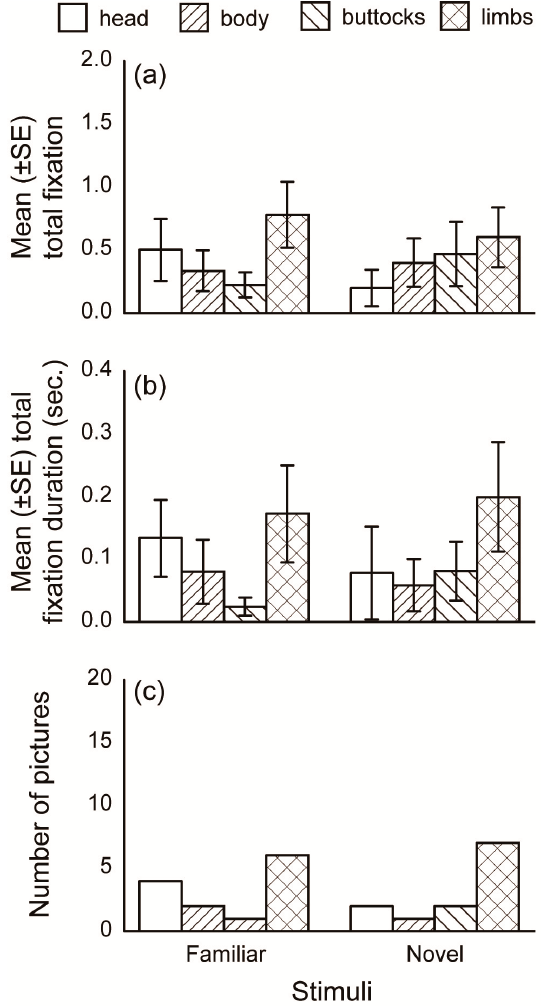
Figure 5. Mean (± SE) fixation number, mean (± SE) total fixation duration, and the number of pictures categorized into each first gazed AOI for the familiar and novel